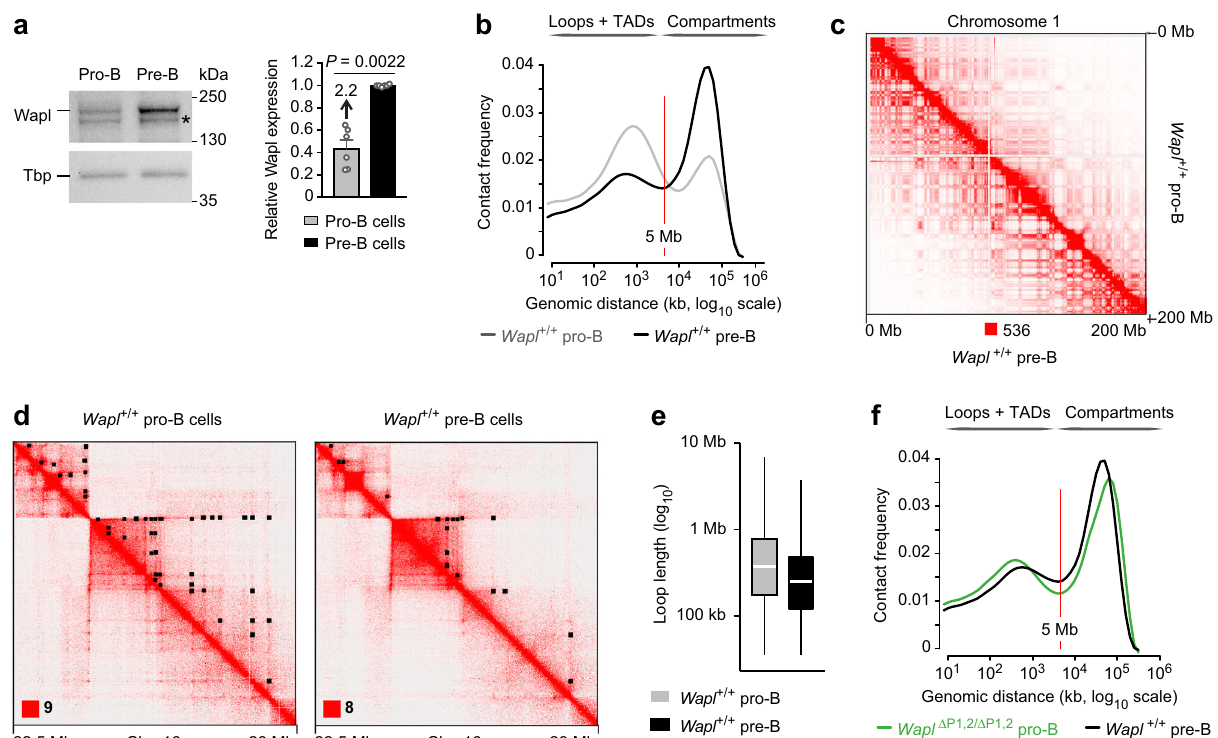
Fig. 3 | Wild-type pro-B and pre-B cells strongly differ in their chromosomal architecture. a Wapl protein expression in ex vivo sorted Rag2 – / – pro-B (gray) and wild-typepre-B (black)cells from the bone marrow, asdeterminedby immunoblot analysis of whole-cell extracts with antibodies detecting Wapl or Tbp (loading control).Markerproteinsoftheindicatedsize(inkilodaltons,kDa)areshowntothe right. A non-speci fi c band is indicated by an asterisk. One of 5 independent experiments is shown, and the quanti fi cation of all immunoblot experiments is indicatedtothe right.StatisticaldataareshownasmeanvalueswithSEMandwere analyzed with the Student ’ s t -test (unpaired and two-tailed). b Comparison of the frequency distribution of intrachromosomal contacts between pro-B and pre-B cellsof Wapl +/+ mice.Thefrequencydistributionofintrachromosomalcontactswas determined as a function of the genomic distance using logarithmically increased genomic distance bins, based on the Hi-C data of Wapl +/+ pre-B cells (black, this